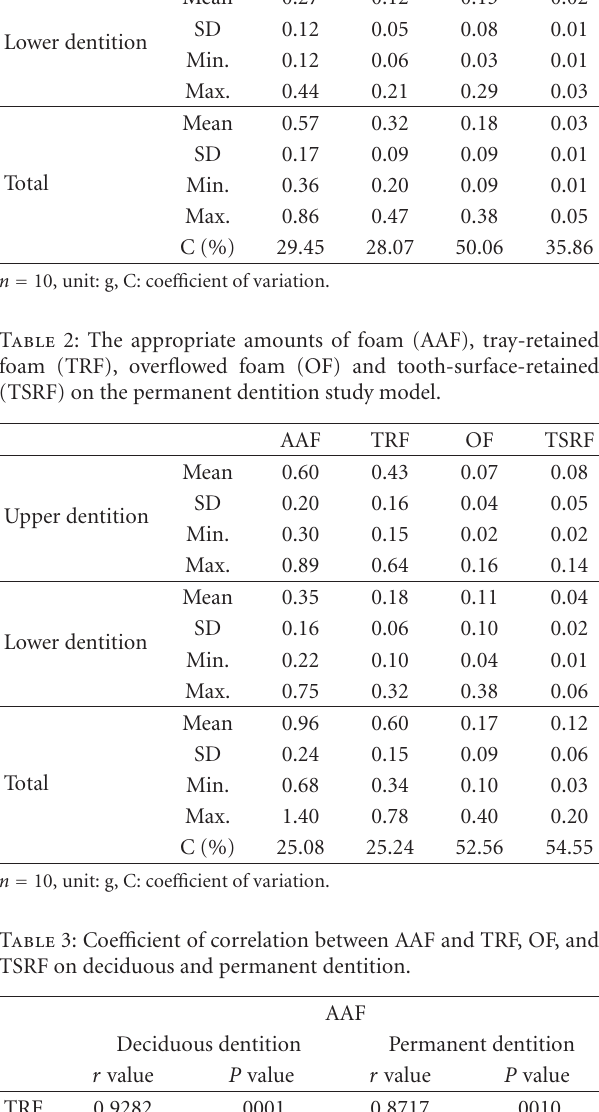
Table 1: The appropriate amounts of foam (AAF), tray-retained foam (TRF), overflowed foam (OF) and tooth-surface-retained (TSRF) on the deciduous dentition study model. AAF TRF OF TSRF Mean 0.30 0.20 0.05 0.02 SD 0.12 0.09 0.03 0.01 Upper dentition Min. 0.12 0.07 0.01 0.00 Max. Mean 0.27 Lower dentition 0.03 Mean 0.57 0.32 Total